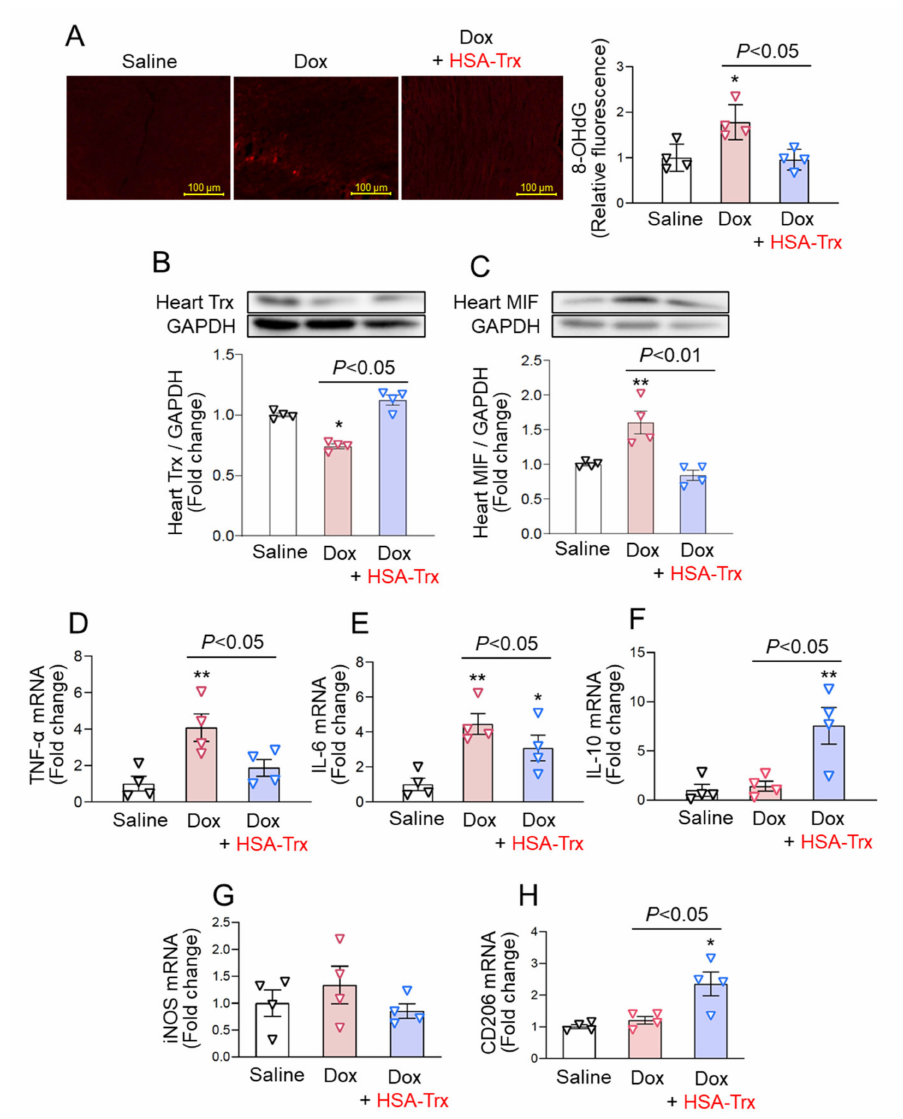
Figure 2. The effect of HSA-Trx on myocardial oxidative stress and inflammation in the hearts of Dox-induced cardiomyopathy model mice. ( A ) Representative photomicrographs of immunostaining for myocardial 8-OHdG (8-hydroxy-2 (cid:48) -deoxygenase) are shown at 4 weeks after the first injection of Dox. Original magnification: × 400. Scale bars represent 100 mm. Image analysis was performed to quantify the extent and intensity of 8-OhdG staining. ( B ) Trx and ( C ) MIF expression in the heart at 4 weeks after the first injection of Dox were assessed by Western blotting. ( D ) TNF- α , ( E ) I IL-6, ( F ) IL-10, ( G ) iNOS and ( H ) CD206 mRNA expression in the heart at 4 weeks after the first injection of Dox were determined by real-time qPCR. PBS or HSA-Trx (400 nmol/kg) was administered i.v. three times a week from 2 weeks after the first injection of Dox. Results are the means ± S.E. ( n = 4). * p < 0.05, ** p < 0.01 compared with the saline injection group (normal